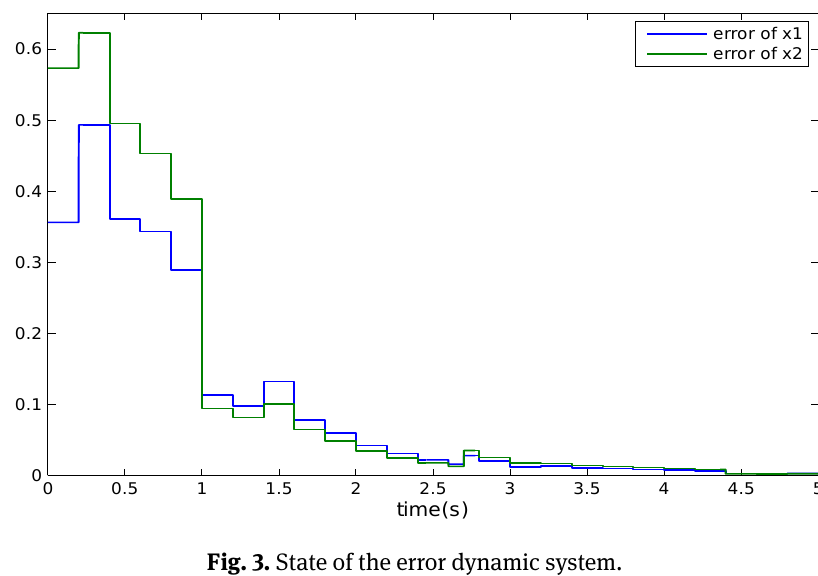
Fig. 3. State of the error dynamic system.